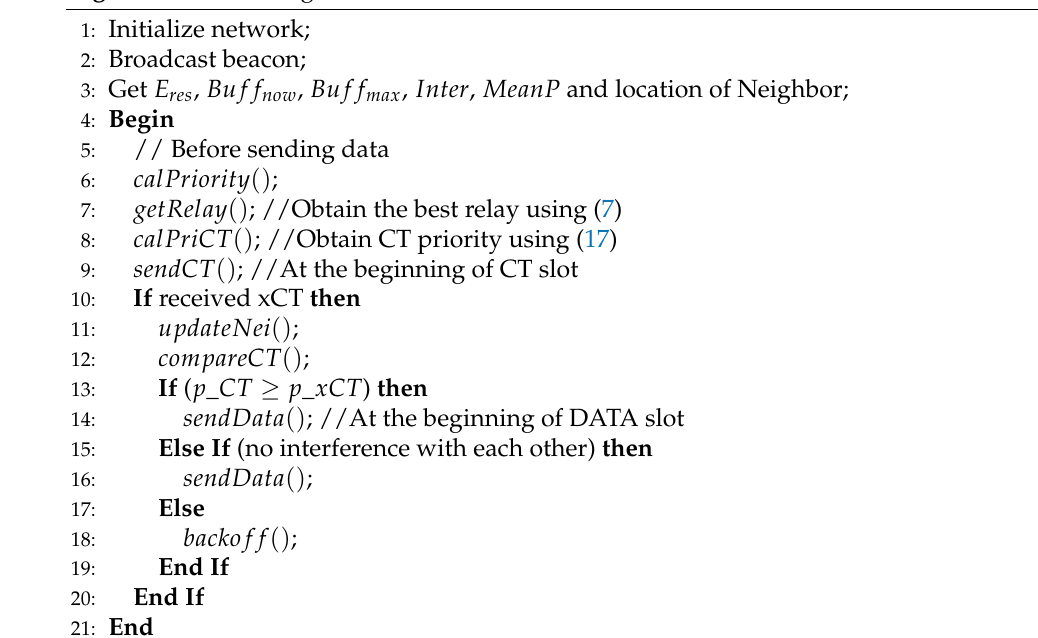
Algorithm 1 CLIC